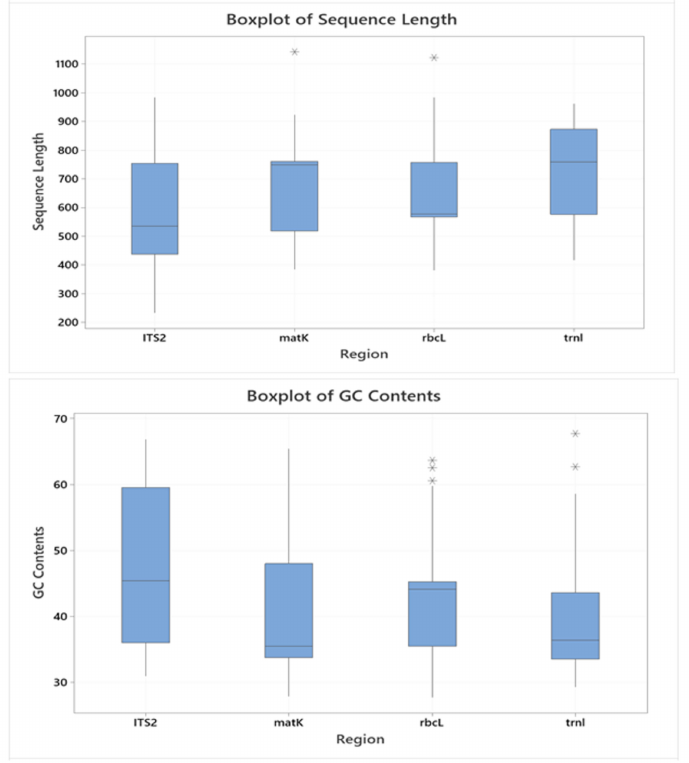
Figure 2. Box plots of the sequence length ( upper ) and GC content ( lower ) of ITS2, matK , rbcL , and trnL of Indonesian medicinal